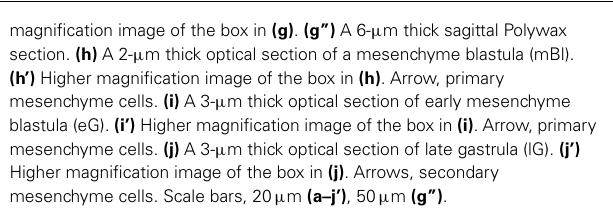
( Figure 6Ha ). Phosphotyrosine also localized at 143 kDa and basic region near pH 5.2 ( Figure 6Hb , arrows). The tail com- prised of a line of dots with the strongest immunoreaction at pH 4.7 region ( Figure 6Hb , inset, arrows). Merged images